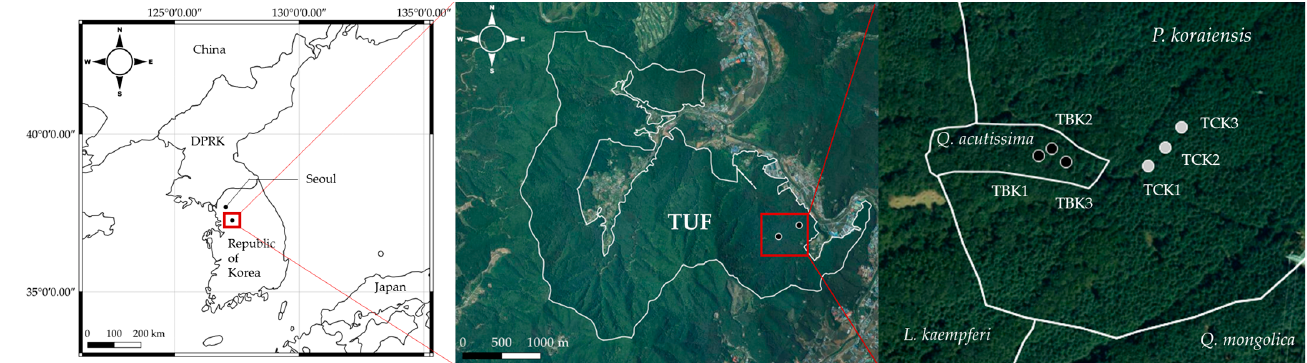
Figure 1. Locations of lysimeters in the Mt. Taehwa University Forest (TUF), Korea.